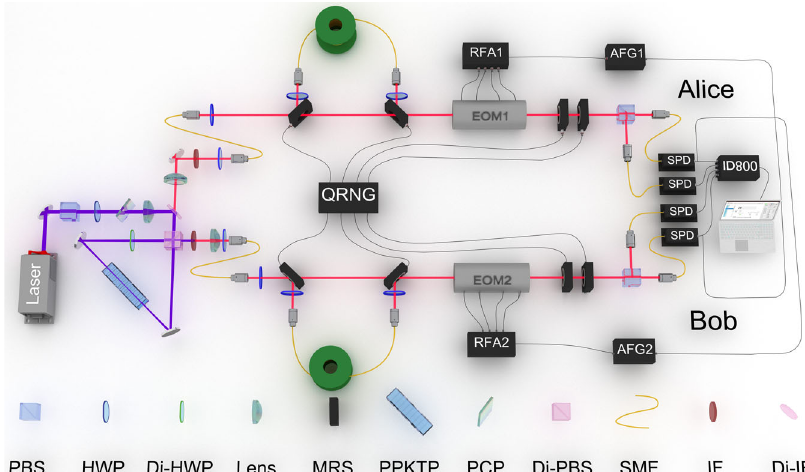
Fig. 2 Experimental setup. The setup includes an entanglement source, two sets of MOS and two sets of TPA. The entanglement source is mainly an SI in a triangle con fi guration, and the generated photon pairs are distributed to two separate parties, namely, Alice and Bob. The MOS consists of two D-Shaped Mirrors mounted in a motorized rotation stage (MRS), and a 100-m single-mode fi ber (SMF) for delaying. Each TPA is composed of one electro-optical modulator (EOM) and one standard polarization analyzer, which consists of one half-wave plate (HWP) and one quarter-wave plate (QWP) mounted in MRSes, and a following polarized beam splitter (PBS) with two single-photon detectors (SPDs) at its two exits. For the Uni-LQCC protocol, the MOS on Alice ’ s side is rotated to be open for the passing photon, which is directly measured by TPA with a randomly selected measurement setting. The other photon on Bob ’ s side is re fl ected in the SMF at Bob ’ s MOS, and then re fl ected into the TPA after emitting from the SMF. Adaptive processing is realized by using the outcome of Alice ’ s measurement to control the measurement setting of Bob ’ s TPA. Technically, Alice ’ s photon sparks the corresponding SPD and the produced pulse triggers an arbitrary function generator (AFG) to output a recognizable signal for the EOM. After amplifying this signal to an adequate amplitude by a radio- frequency ampli fi er (RFA), the EOM can be driven to perform a required operation on the passing photon; thus, Bob ’ s measurement is adaptive to the outcomes of Alice ’ s measurement. The coincidence is recorded and analyzed by an ID800 (ID Quantique). The Bi-LQCC protocol can be implemented by randomly switching the role of Alice and Bob. The randomness of the measurement setting and communication direction is realized by controlling the TPA and MOS with the QRNG, respectively. Di dichroic, MMF multi-mode fi ber, IF interference fi lter, SMF single-mode fi ber, PCP phase compensation plate, L